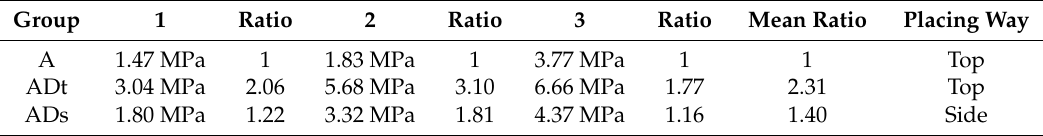
Figure 7. Destruction types in the specimen during the flexural test. ( a ) Group A; ( b ) Group Ads; ( c ) Group ADt1 and ADt2; ( d ) Group ADt3. Table 4. Flexural strength. Group A: Specimens without microcrystalline decoration surface; Numbers 1–3: Three different batch compositions of the main raw materials; ADt: Decoration surface on the top; ADs: Decoration surface on the side.